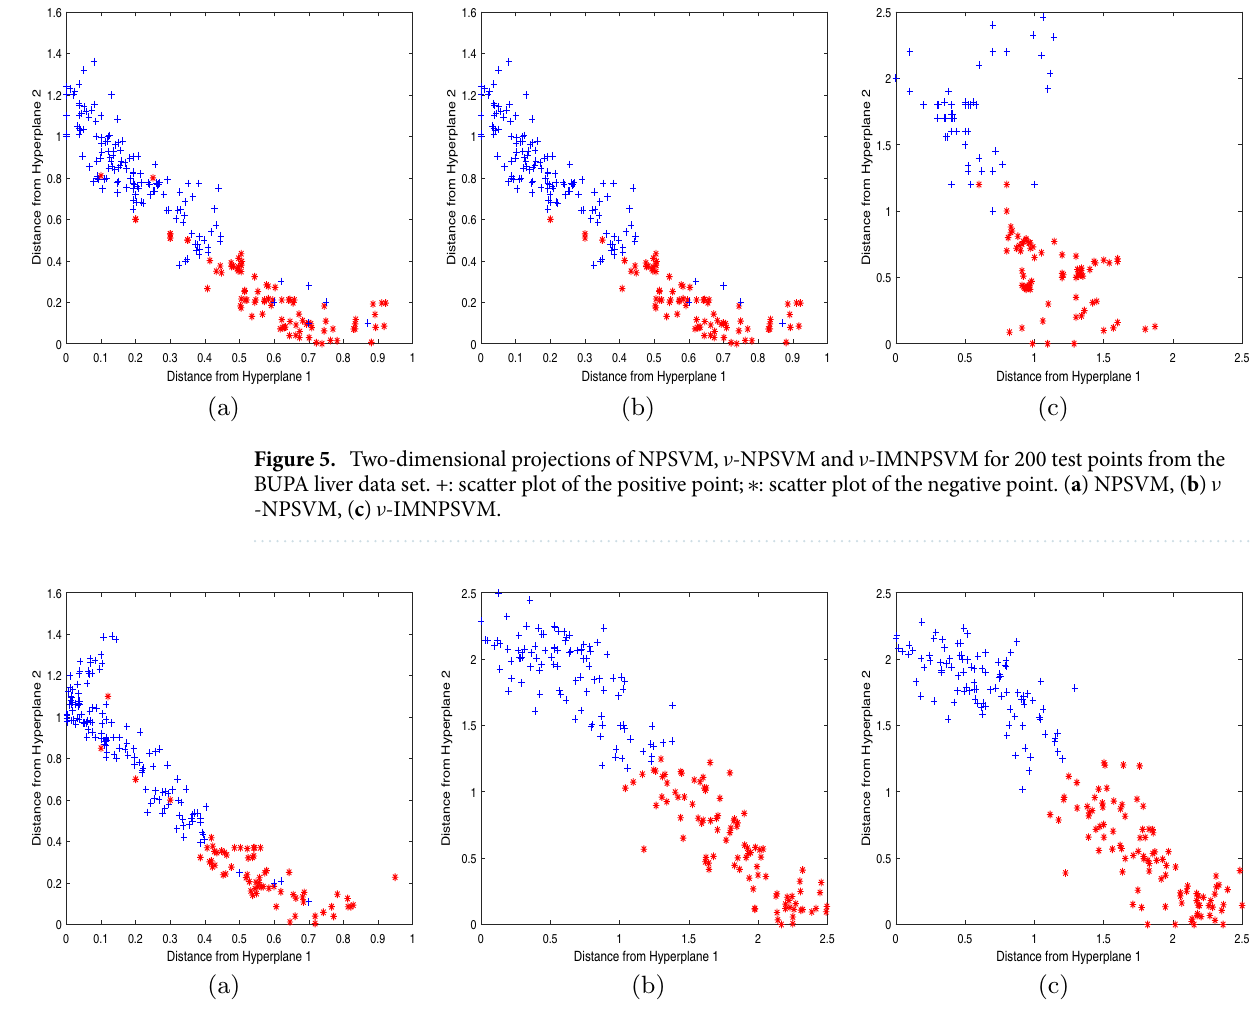
Figure 6. Two-dimensional projections of NPSVM, ν -NPSVM and ν -IMNPSVM for 200 test points from the Heart-Statlog data set. +: scatter plot of the positive point; ∗ : scatter plot of the negative point. ( a ) NPSVM, ( b ) ν -NPSVM, ( c ) ν